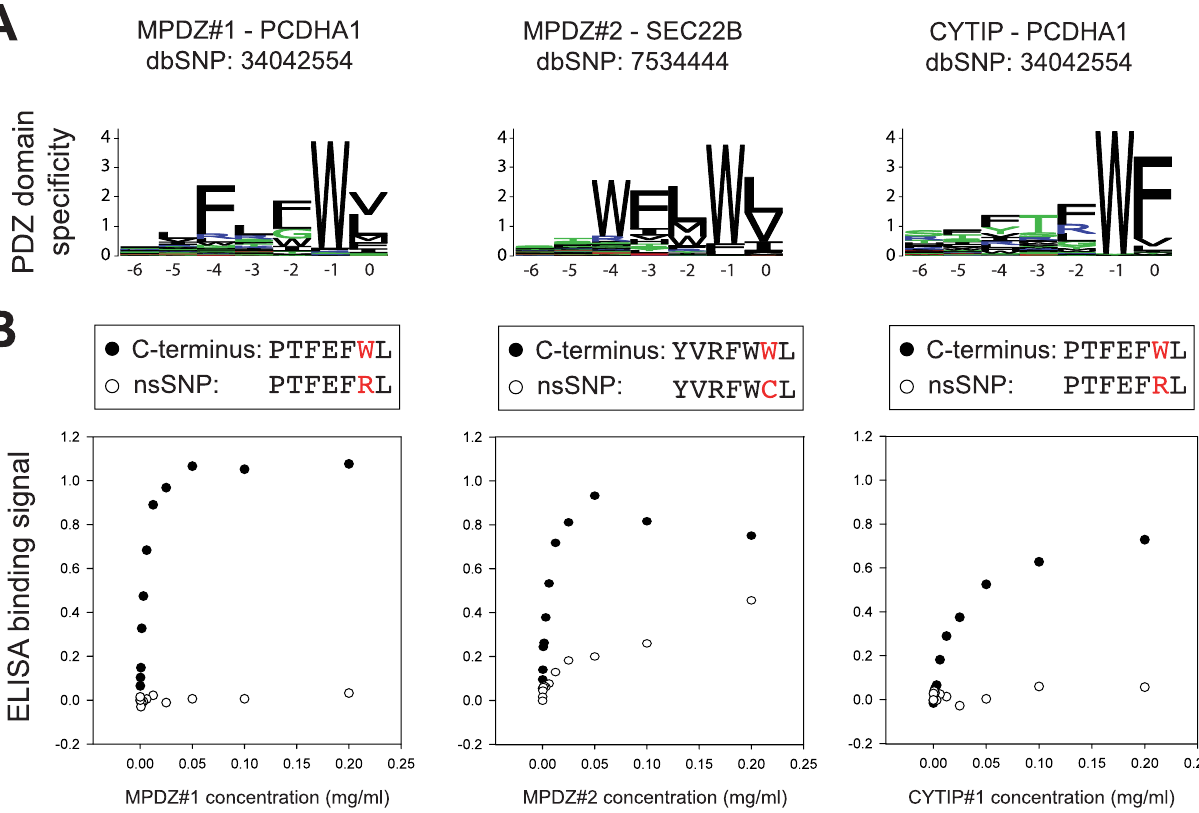
Figure 4. PDZ binding is affected by nsSNPs. (A) Sequence logo representing the peptide binding profile of the first and second PDZ domain of Multiple PDZ Domain Protein (MPDZ) and the PDZ domain of cytosine interacting protein (CYTIP) [19]. The interactions predicted to be disrupted by an nsSNPs are shown above. (B) Saturation binding of MPDZ # 1, MPDZ # 2 and CYTIP to peptides derived from sequence logos shown in Figure 4A (filled circle) and related peptides containing nsSNPs (open circles). The ELISA signal at 450 nm is plotted vs. the PDZ concentration in mg/ml. Note the C-terminus of PCDHA1 corresponds to the third isoform in UniProt (Q9Y5I3-3).